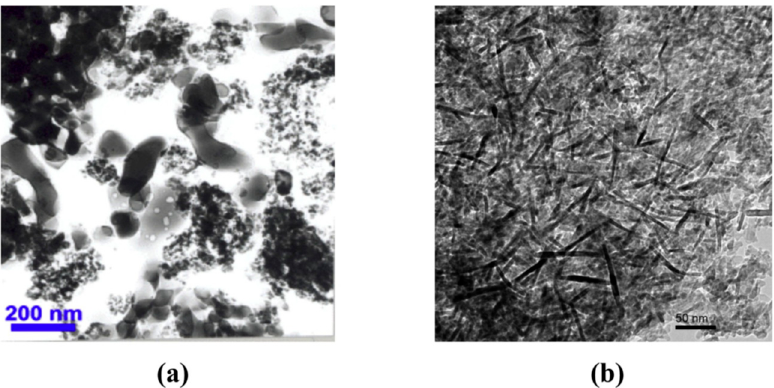
Figure 5. TEM images of nanoalumina as ( a ) nanospheres and ( b ) nanorods. Reprinted with permission [51].